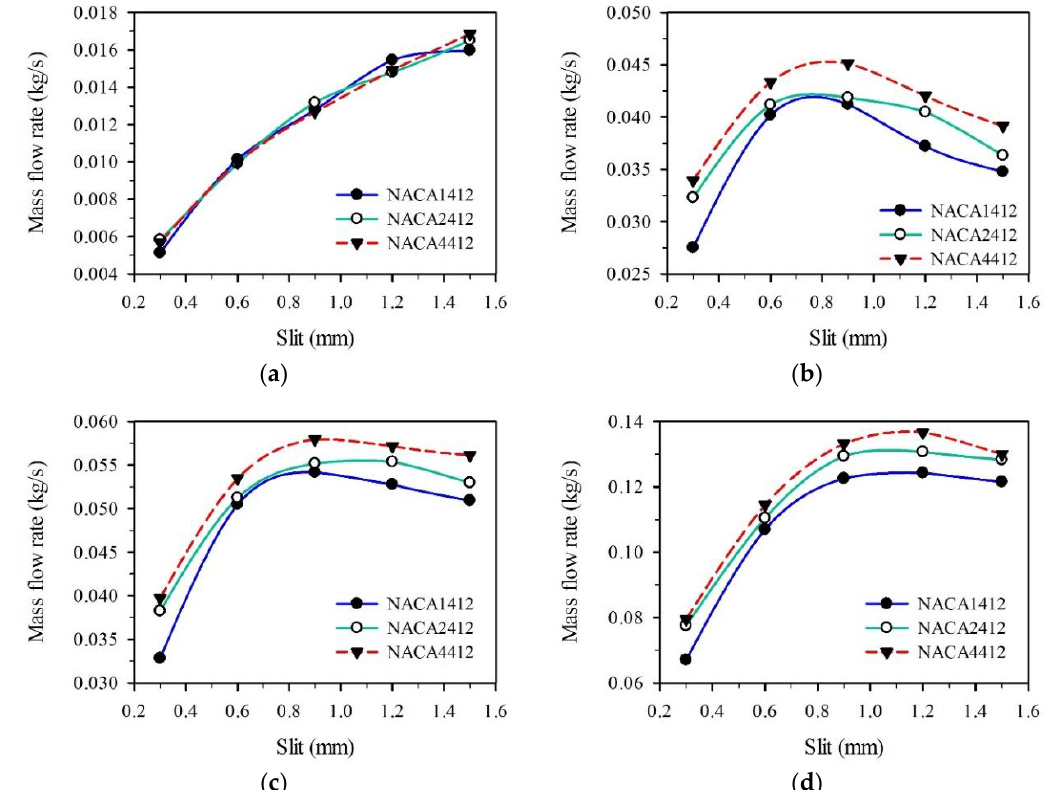
Figure 11. Mass flow rate ( a ) at the inlet of Plane S, ( b ) on Plane M1, ( c ) at the outlet of Plane M2, and ( d ) at the outlet of Plane M3 in relation to the slit sizes of the NAC1412, NACA2412, and NACA4412 airfoils.